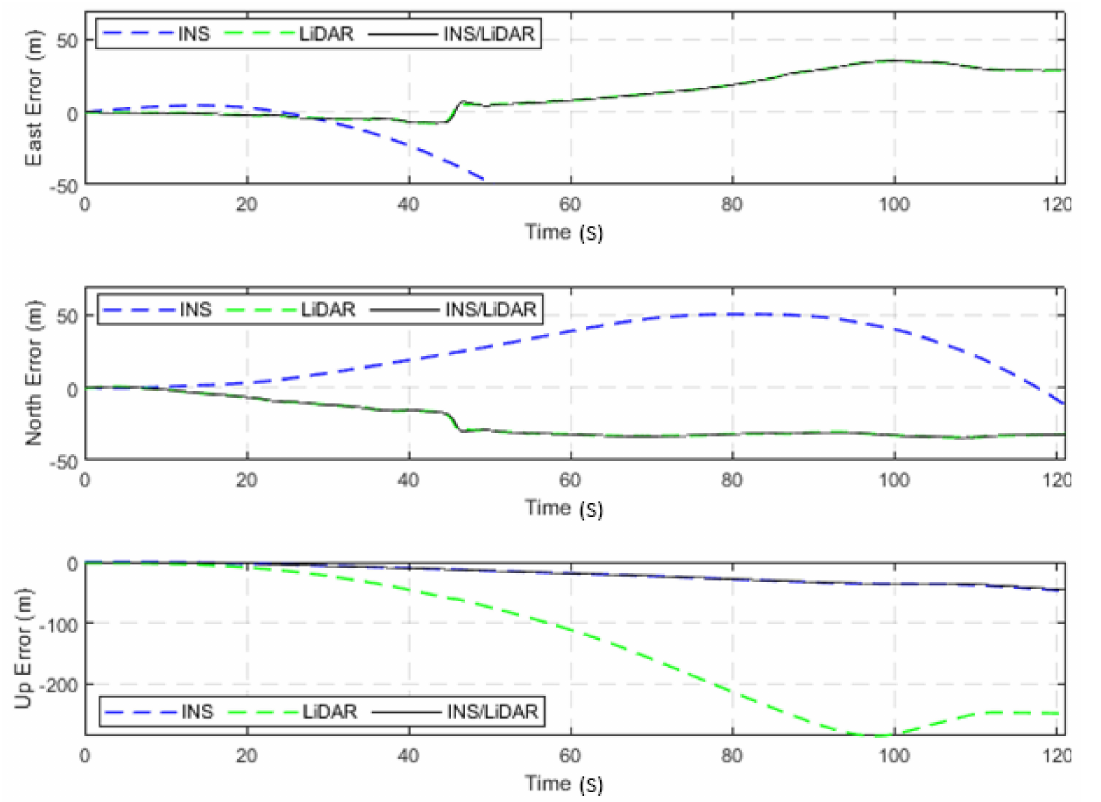
Figure 16. D-42—complete GNSS signal outage: position errors (ENU).